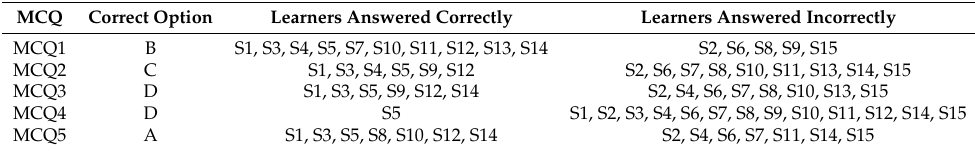
Table 1. Learner response for each MCQ.